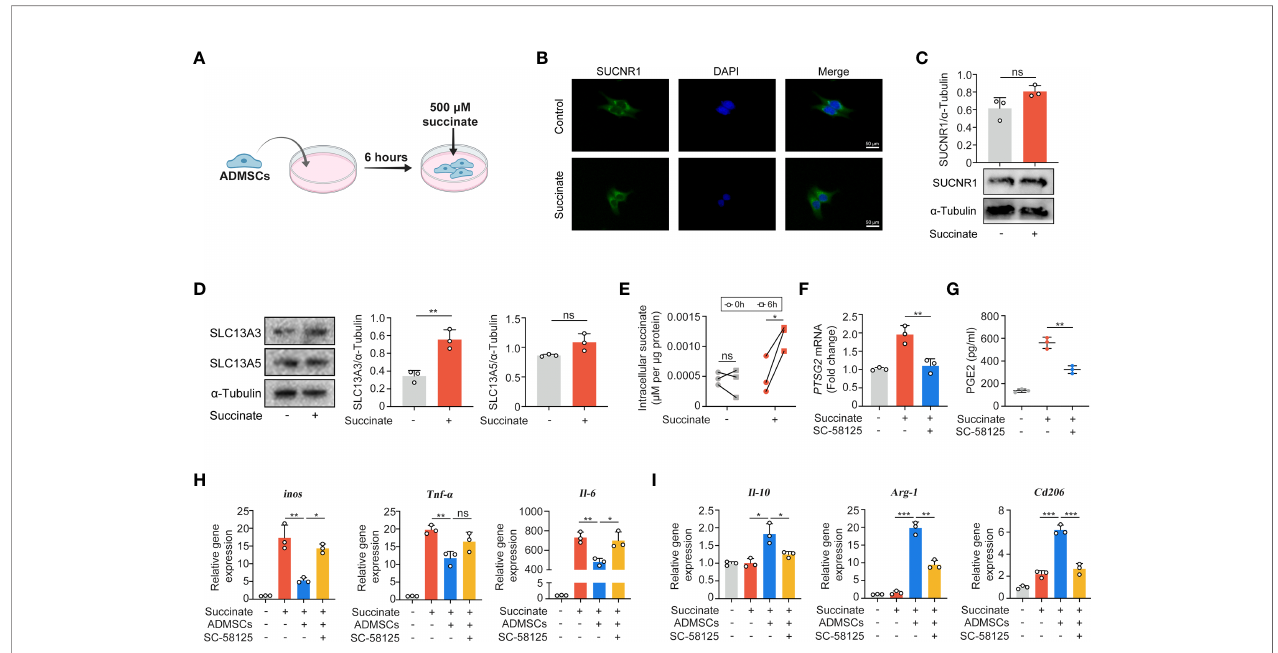
FIGURE 5 | Macrophage-derived succinate triggered ADMSCs to uptake succinate and secreted PGE2 to further shift macrophages from M1 phenotype to M2. (A) Schematic diagram of ADMSCs exposed to succinate in vitro . (B, C) Representative microscopy images (B) and western blot analysis (C) of SUCNR1 in ADMSCs. (D) Protein levels of SLC13A3 and SLC13A5 in ADMSCs supplemented with or without succinate. (E) Concentrations of intracellular succinate in ADMSCs. (F, G) Ptsg2 gene expression (F) and PGE2 concentrations (G) in ADMSCs. (H, I) Gene expression of M1-characterized cytokines (H) and M2- characterized cytokines (I) in BMDMs. (*p < 0.05; **p < 0.01; ***p < 0.001; ns, no signi fi